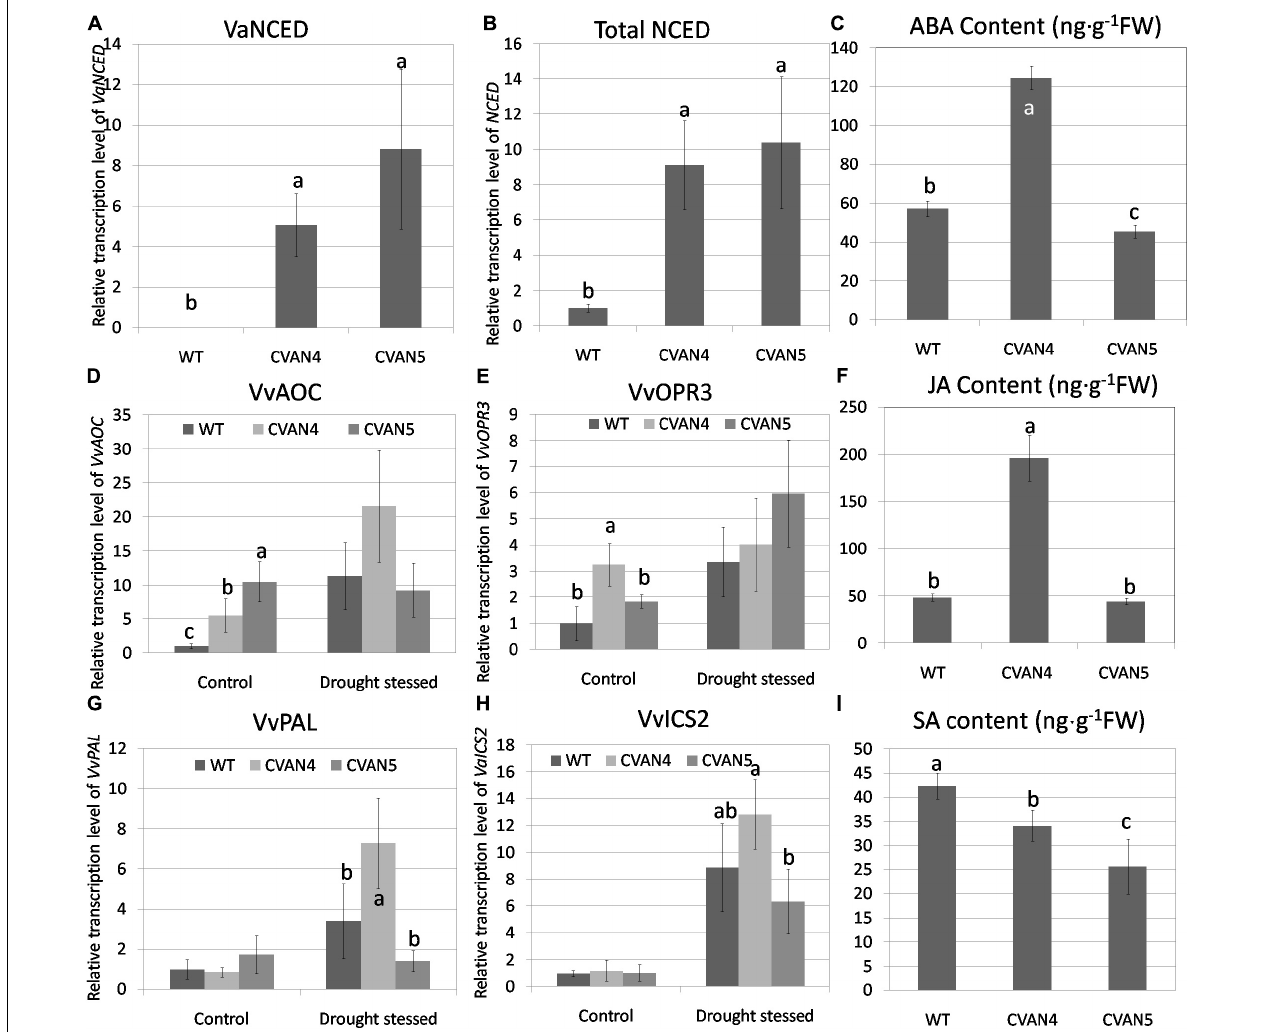
FIGURE 4 | Determination of phytohormone and relative transcript levels of phytohormone-related genes. VaNCED1 mRNA content (A) , total NCED mRNA content (B) , abscisic acid (ABA) content (ng/g) (C) , VvAOC mRNA content (D) , OPR3 mRNA content (E) , JA content (ng/g) (F) , VvPAL mRNA content (G) , VvICS mRNA content (H) , and SA content (ng/g) (I) of the WT and transgenic lines under normal conditions. The leaves were obtained for the total RNA isolation. EF α and Vitis actin were used as two reference genes for data normalization. Data are expressed as the mean ± SD from 3 independent experiments. Different letters indicate significant differences ( P < 0.05) determined by Duncan’s multiple range test ( P < 0.05) using SPSS statistical software. Gene expression in the WT plants under the same conditions was defined as 1. Because VaNCED1 cannot be detected in WT, The expression level of VaNCED1 in transgenic plants are calculated by defined total NCED in WT as